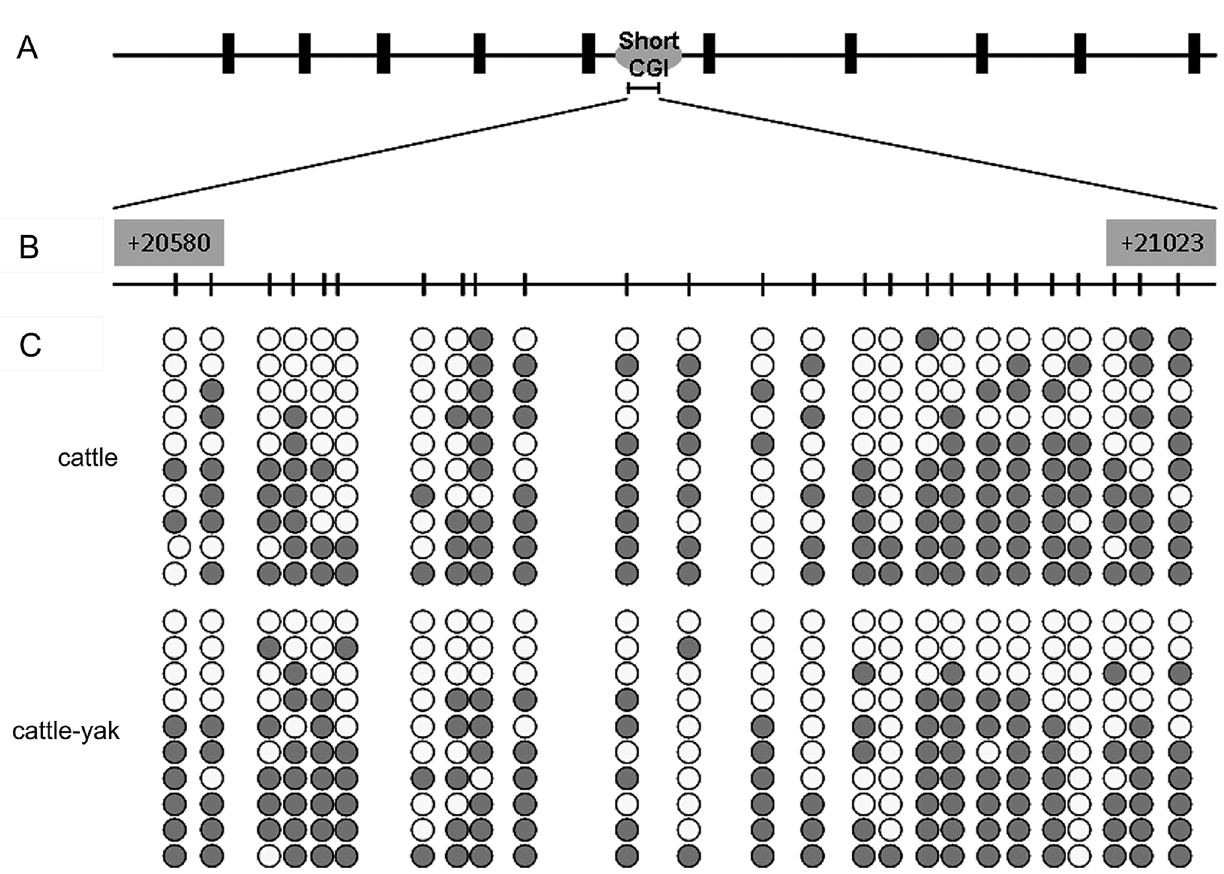
Fig 2. The methylation profile of the short CpG island in the b Boule gene body. (A) Schematic diagram of the short CGI within the b Boule gene body. (B) Schematic depiction of the CpG sites for methylation analysis. Nucleotide numbering is relative to +1 at the initiating ATG codon. The short vertical bars represent the CpG dinucleotides. (C) Methylation statuses of b Boule in testes of cattle and cattle-yak hybrids. Each line represents an individual bacterial clone that was sequenced. Open circles indicate unmethylated CpG sites. Black circles indicate methylated CpG sites.